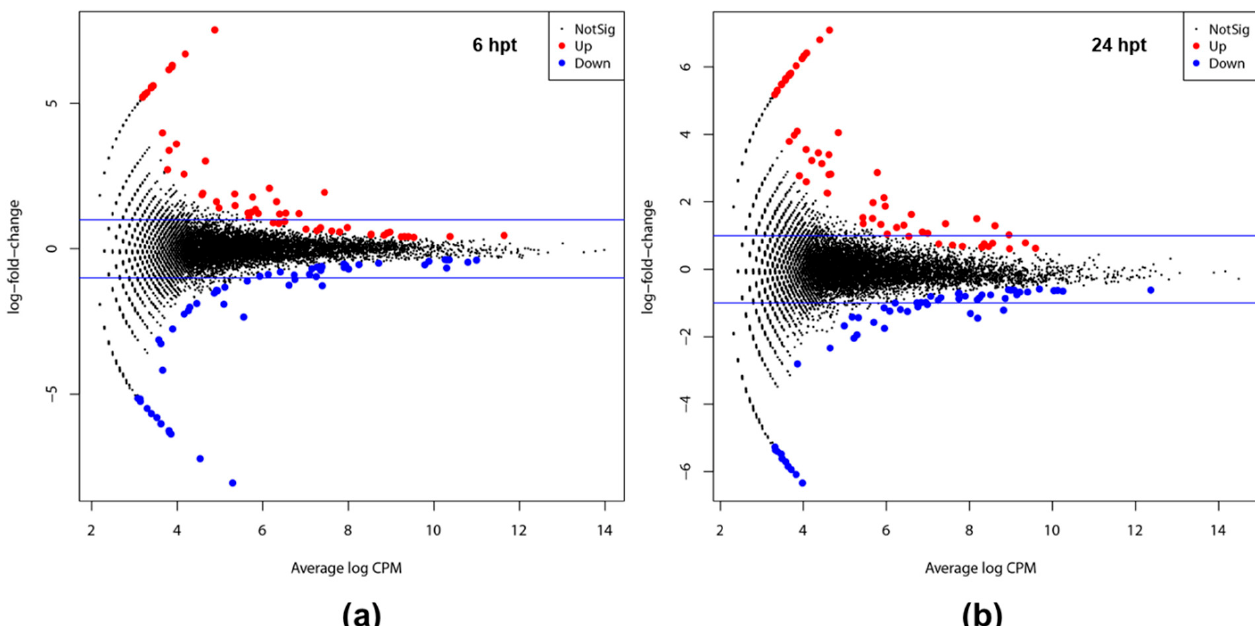
Figure 1. MA plot based on the EdgeR analysis showing differences in measurements between SSG-treated and control plants at 6 ( a ) and 24 hpt ( b ). M, log-fold-change ( − log 2 FC) (ratio of gene expression calculated between the control and SSG treated plants). A, Average log CPM, or log 2 (counts per million abundances, CPM). Schemes follow the same formatting.